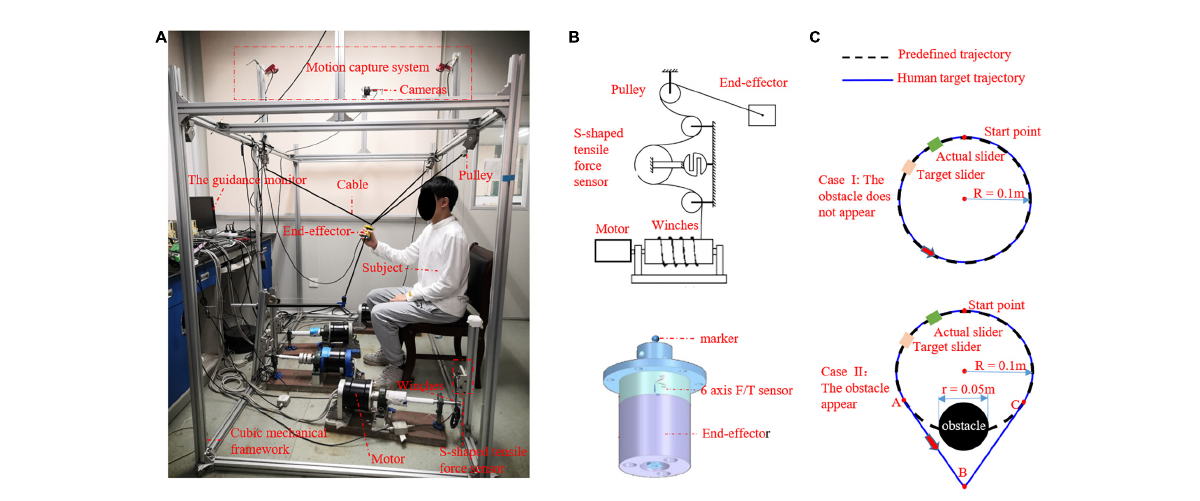
FIGURE3 (A) Prototype of 3-degrees of freedom (DOFs) cable-driven rehabilitation robot (CDRR), (B) one cable transmission mechanism and actuator module, (C) the graphical guidance interface.